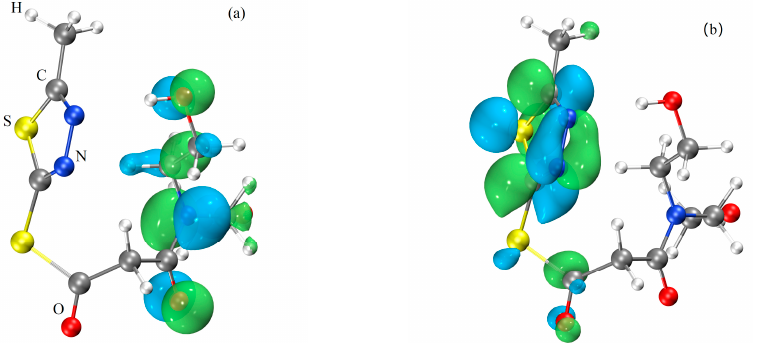
Figure 8. The frontier molecular orbital density distribution of the TSCA molecule: HOMO ( a ) and LUMO ( b ). Table 4. Derived quantum chemical parameters for TSCA calculated by the DFT/B3LYP method.